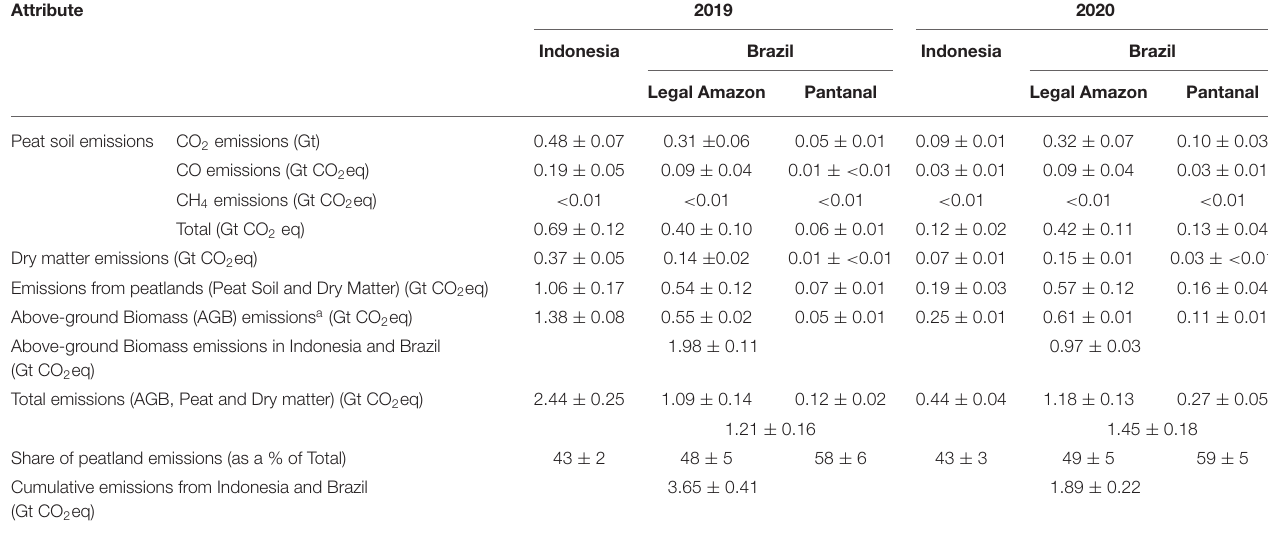
TABLE 1 | GHG impact of deforestation fires in Indonesia and the Legal Amazon in Brazil, 2019 and 2020, calculated in this work. Attribute